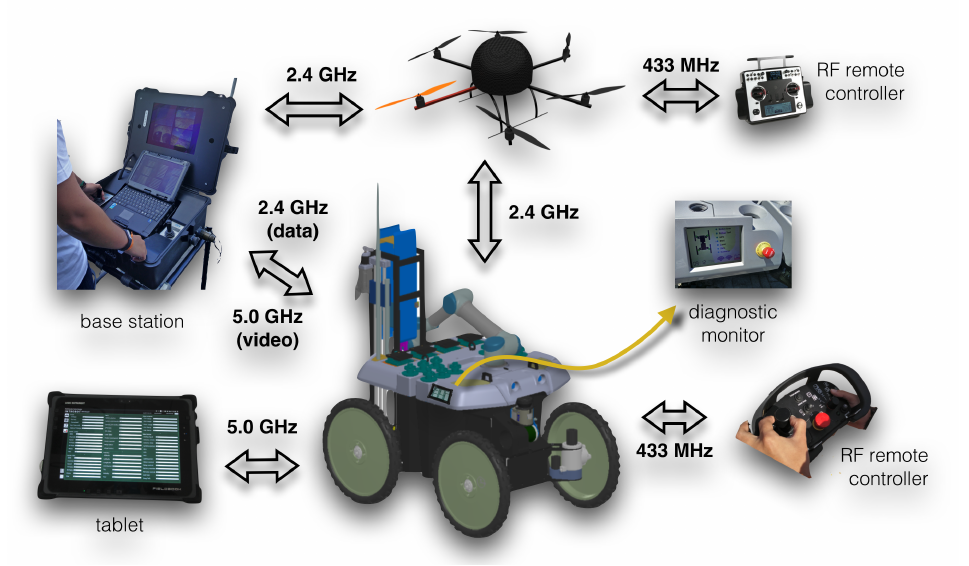
Figure 11. Human-robot interaction devices and teamwork underlying communication